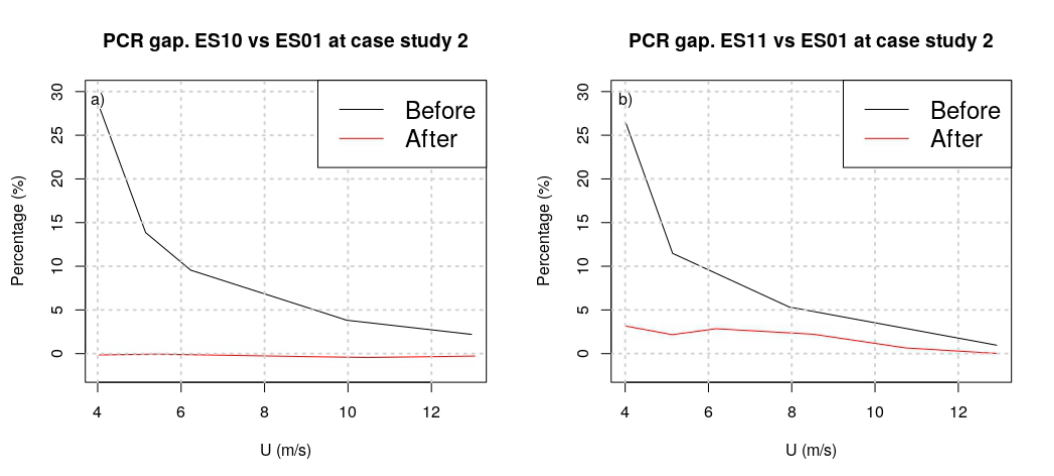
Figure 12. PCR gap reduction after calibration for turbines ES10 ( a ) and ES11 ( b